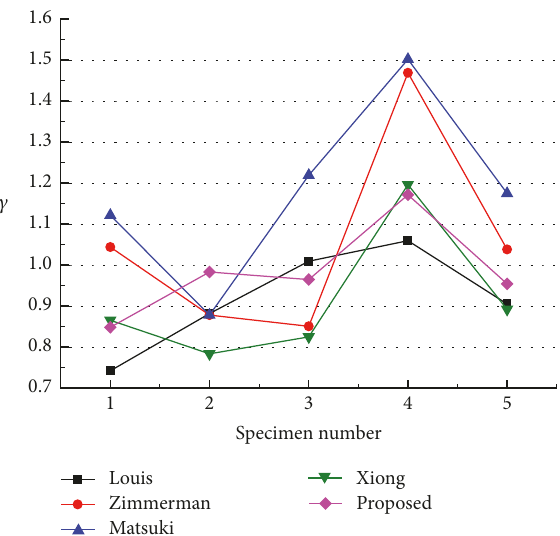
Figure 16: 𝛾 values of hydraulic aperture for the fracture specimens evaluated by different